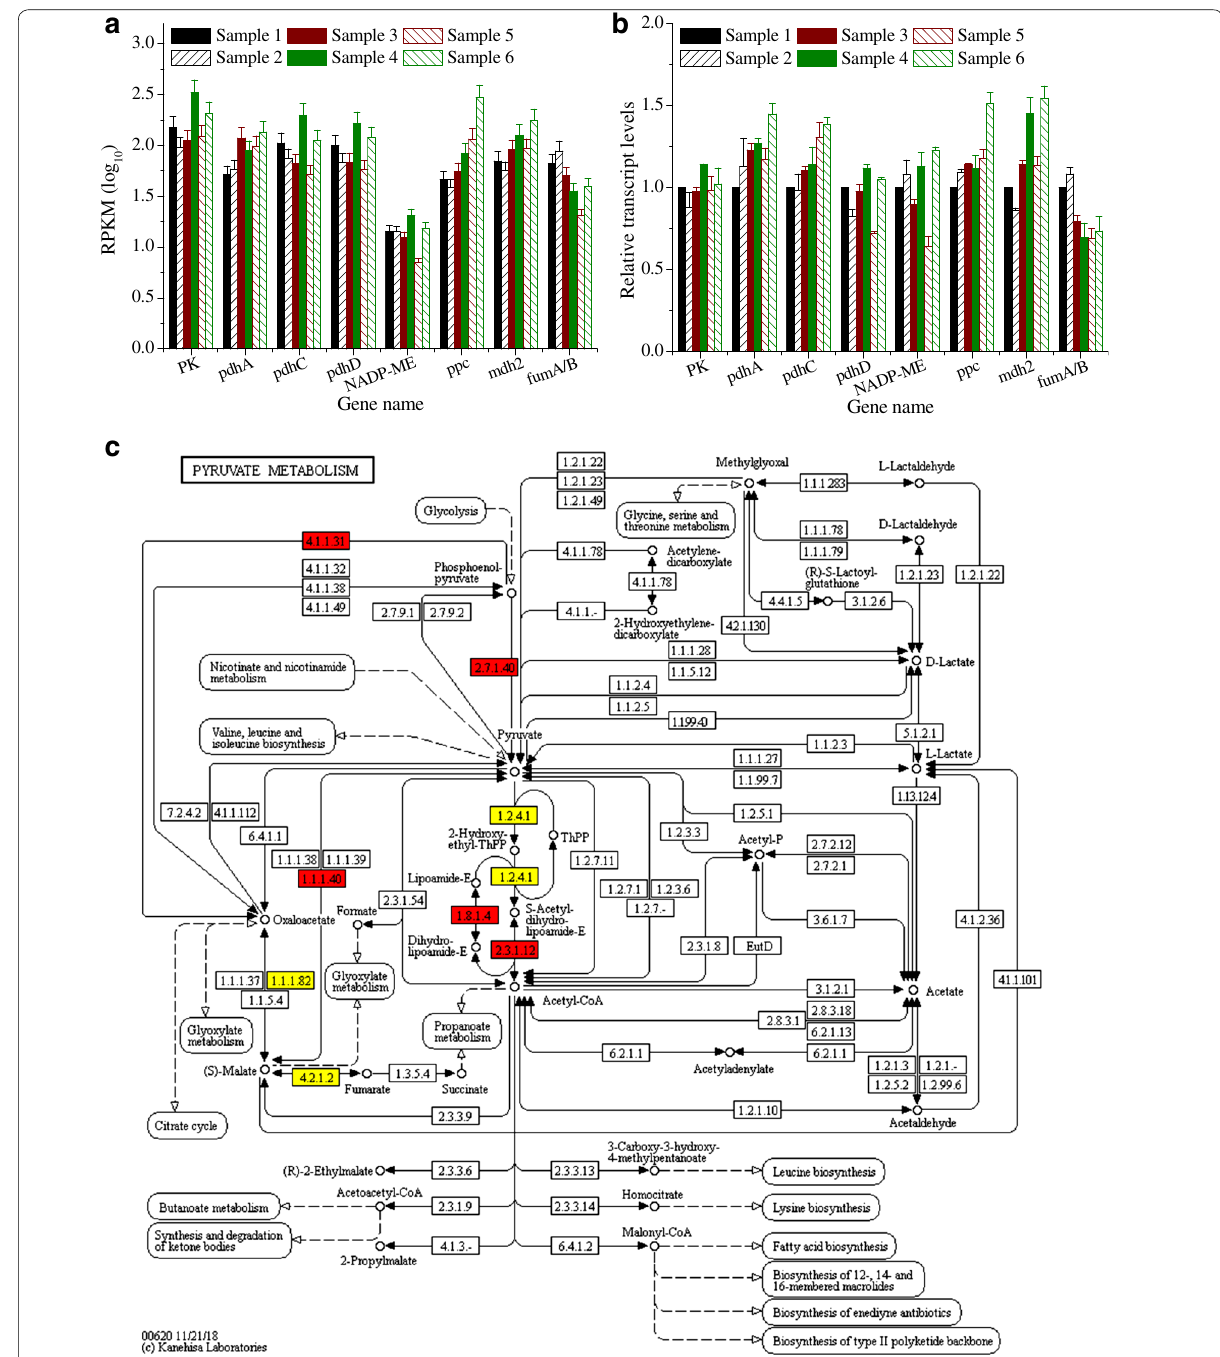
Fig. 6 RPKM and unigene transcription changes involved in pyruvate metabolism pathways of H . pluvialis . a , b represent RPKM changes ( a ) and relative transcript level changes ( b ) involved in pyruvate biosynthesis pathways of H . pluvialis in control group (1235 route) and treatment group (1246 route), respectively. To calculate genes transcript level, Sample 1 was regarded as control; comparing with control group, the gene transcription changes of the treatment group were presented in KEGG pathway ( c ). Sample 1, Sample 2 and Sample 3 were the heterotrophic cells at 100 h, 250 h, and 550 h, respectively; Sample 4 was Sample 2 cells induction for 0.5 day; Sample 5 was Sample 3 cells induction for 6 days; Sample 6 was the Sample 2 cells induction for 6 days. Yellow represents both down- and up-regulation gene, and red represents upregulation gene. Data shown as mean SD, and number of replications is two ( n ± =